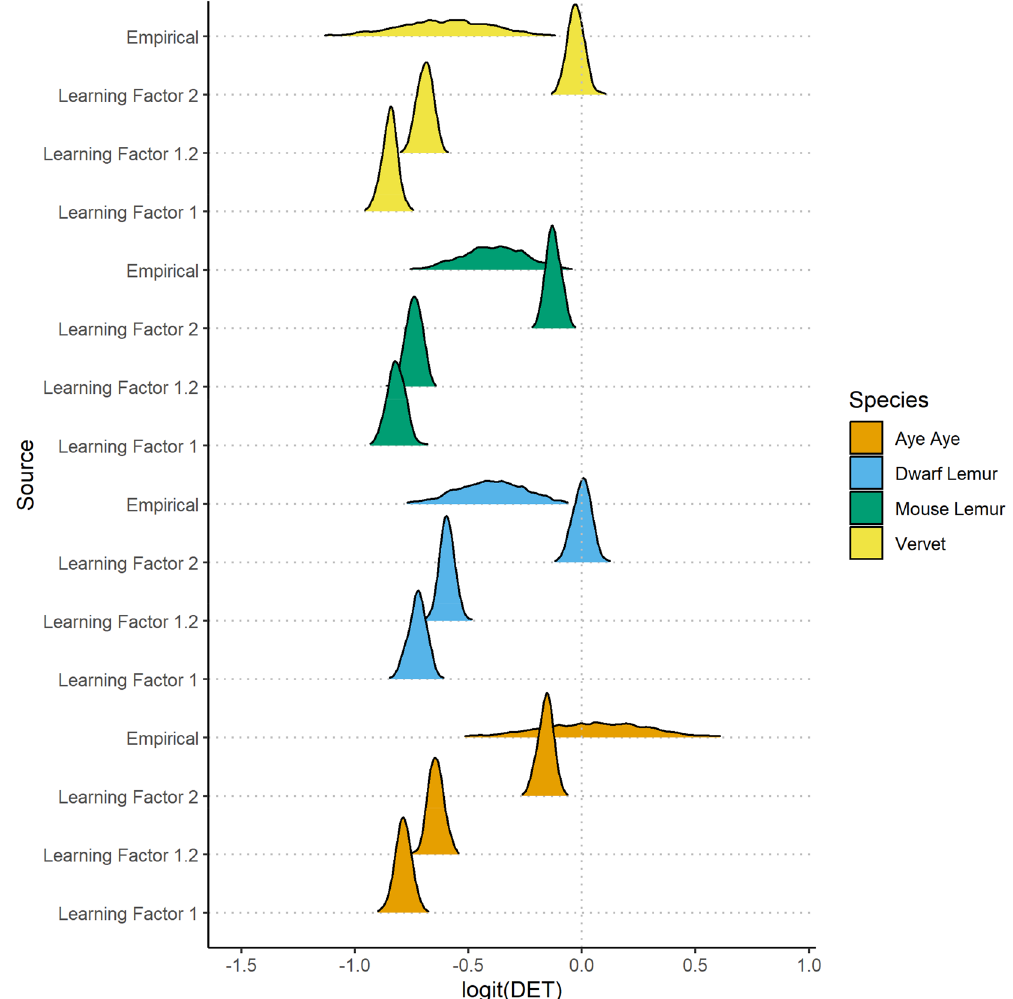
Figure 4. Posterior distributions of alpha estimates. Estimates of alpha (related to DET through a logit link- function) are calculated by summing the mean intercept ( α 0 ) with relevant coefficients for species, source, and interaction. Colored plots represent the density of alpha estimates in the posterior for each possible combination of these coefficients, arrayed along the y-axis. The y-axis labels denote the source and plot color denotes the species. The scale of the density axis (height) is not shown, but consistent across all